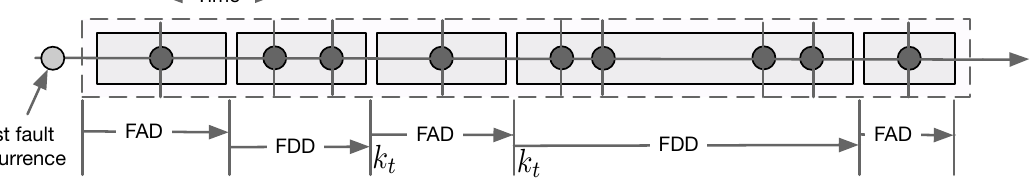
Figure 6. Fault detection process.